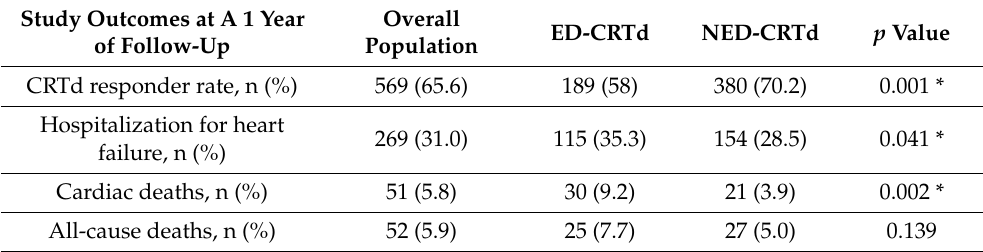
Table 2. Clinical outcomes at 12-month follow-up for ED-CRTd vs. NED-CRTd patients. CRTd: cardiac resynchronization with a defibrillator; ED: endothelial dysfunction; NED: non-endothelial dysfunction; n: number. *: statistically significant, with p <